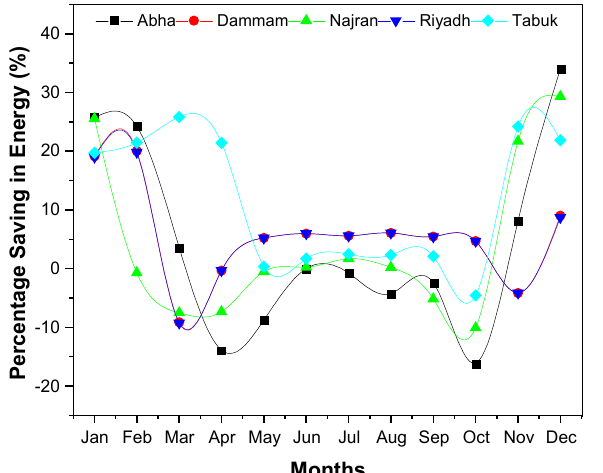
Figure 6. Percentage saving in monthly energy consumption by adding PU insulation for different climates.